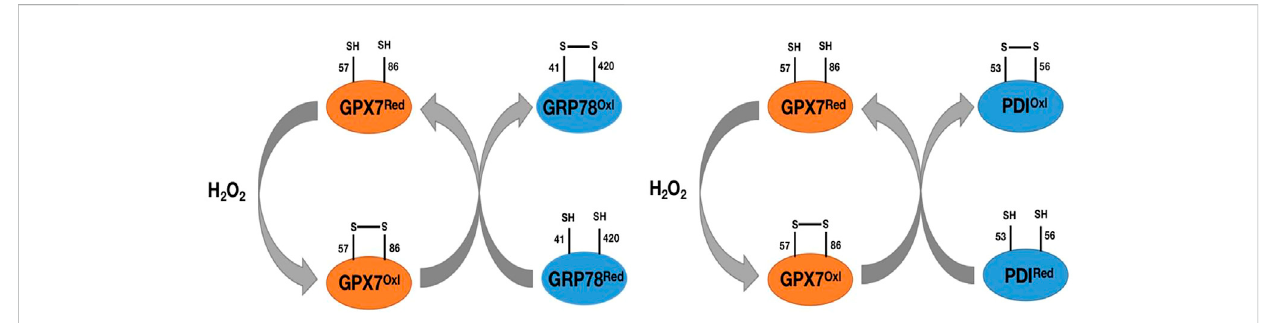
FIGURE 5 Pat plot of the chaperone proteins GRP78 and PDI versus GPX7. H2O2 catalyzes the formation of disul fi de bonds between Cys57 and Cys86 on GPX7, prompts the transformation of GPX7 from reduced to oxidized form, and then oxidized GPX7 promotes the formation of disul fi de bonds between Cys41 and Cys420 (Cys53 and Cys56) on GRP78 (PDI) and enhances the activity of GRP78(PDI) protein.